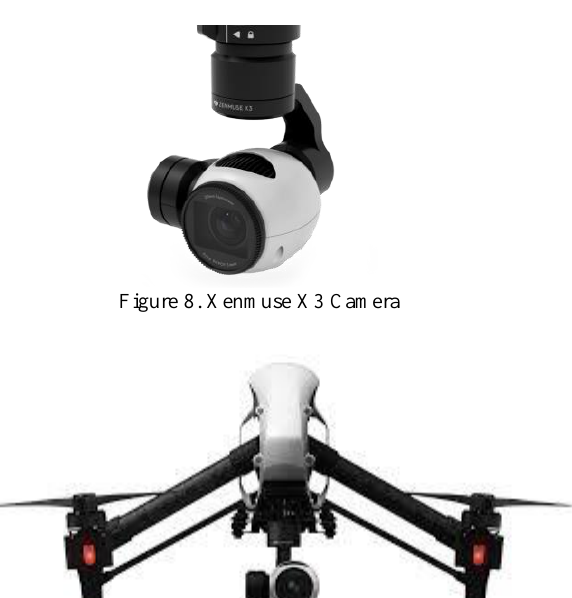
Figure 7. Flow of Aerial Image Acquisition